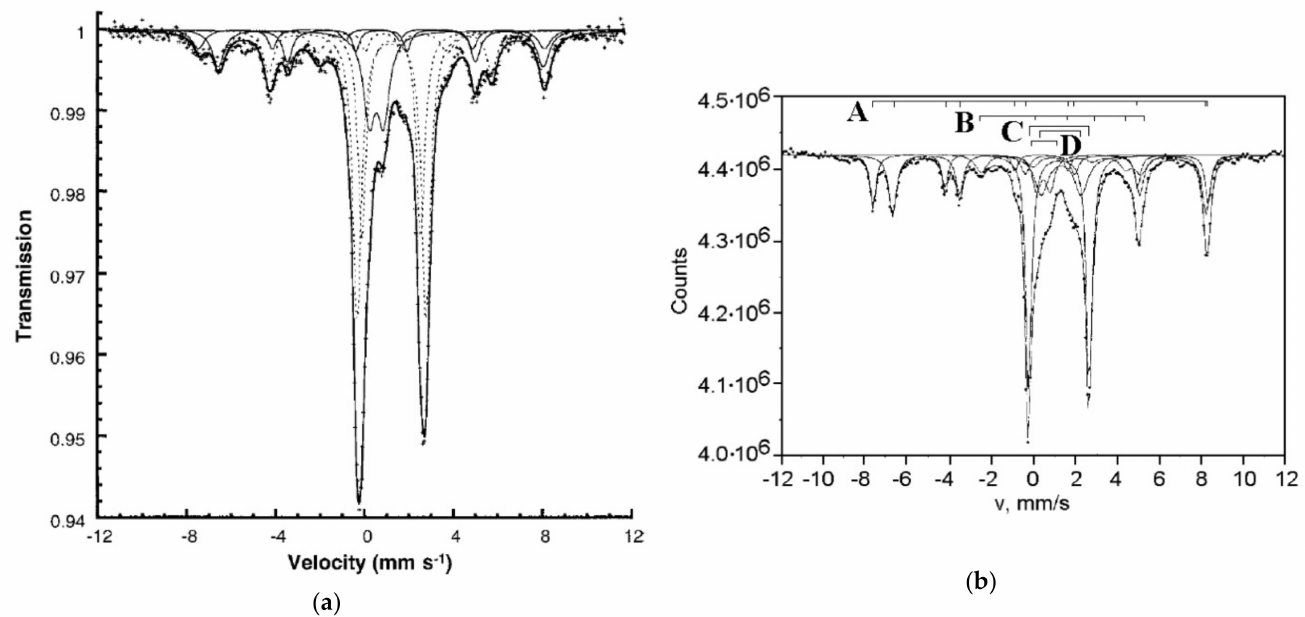
Figure 2. Room temperature Mössbauer spectra of carbonaceous chondrites: ( a ) Vigarano CV3 and ( b ) Kaba CV3 (explana- tion of indicated components see in the text). Adapted from References [40,41],